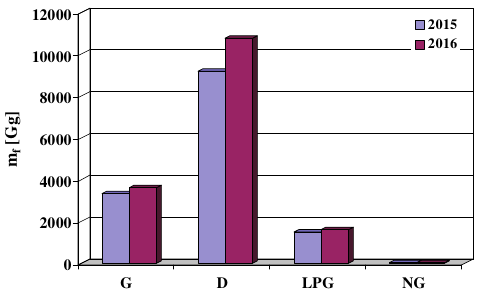
Fig. 3. Fuel consumption from motor vehicles in years 2015 and 2016